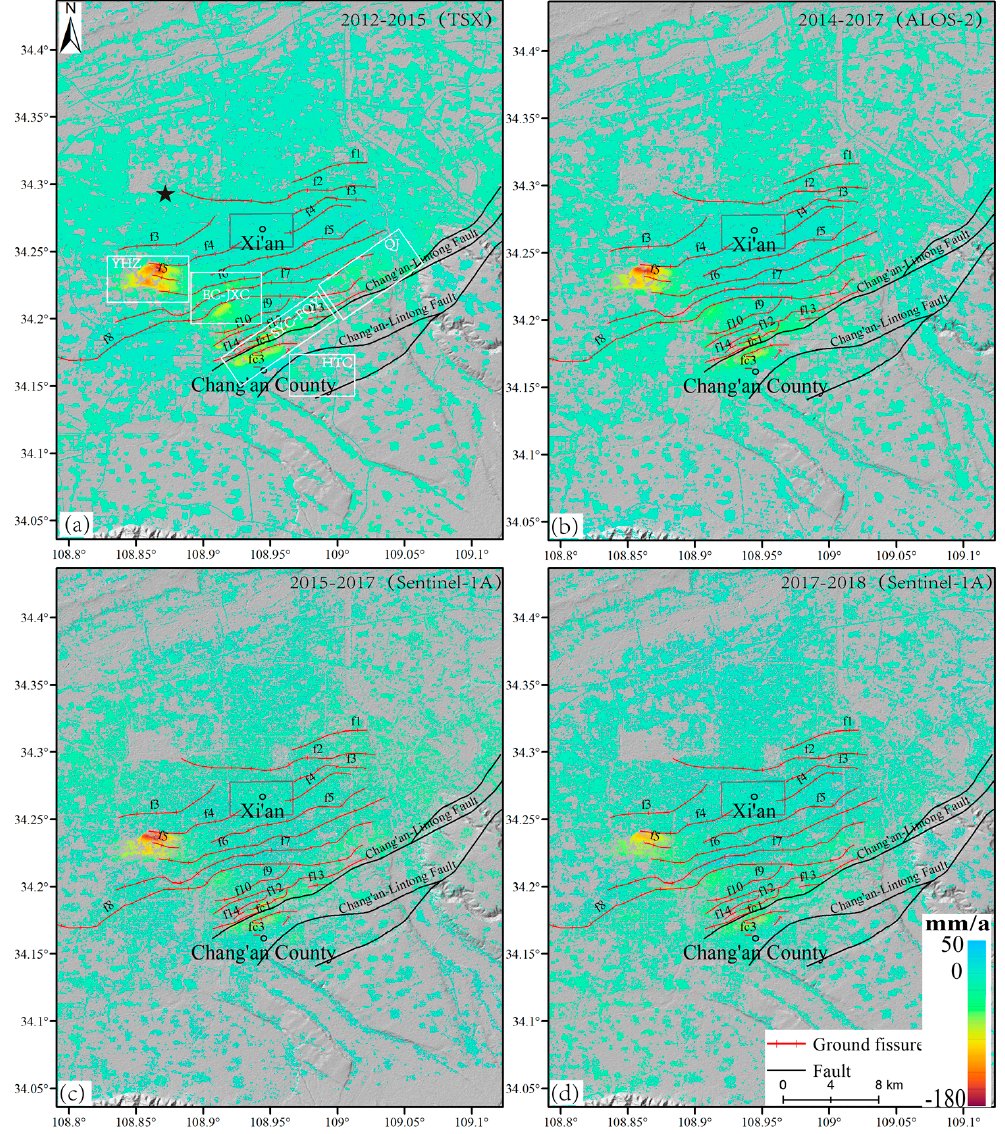
Figure 3. Average vertical deformation rate maps of Xi’an from 2012 to 2018, derived from TerraSAR-X ( a ), ascending ALOS-2 ( b ) and Sentinel-1A Satellite ( c , d ). Positive values in blue represent movement uplift, and negative values in red represent subsidence. The black star in ( a ) indicates the reference